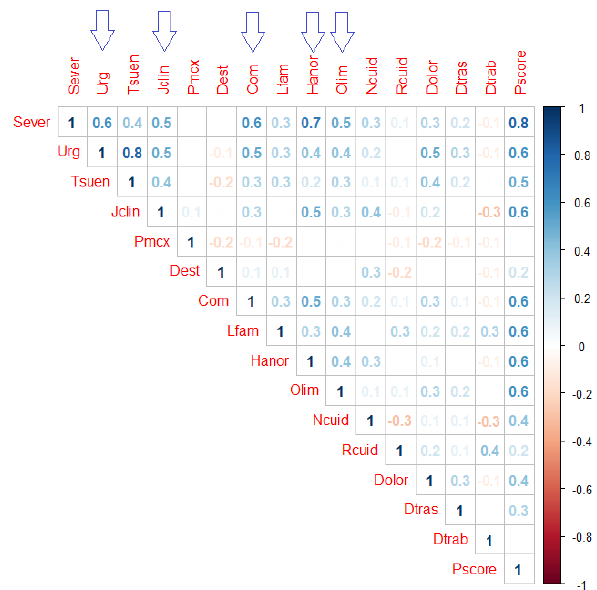
Figure 4. Correlation matrix of the variables used in ( 2 ). Multicollinearity is displayed when comparing the variable with the highest fit, Sever , with respect to the predictor variables Urg, Jclin, Com, Hanor, Olim